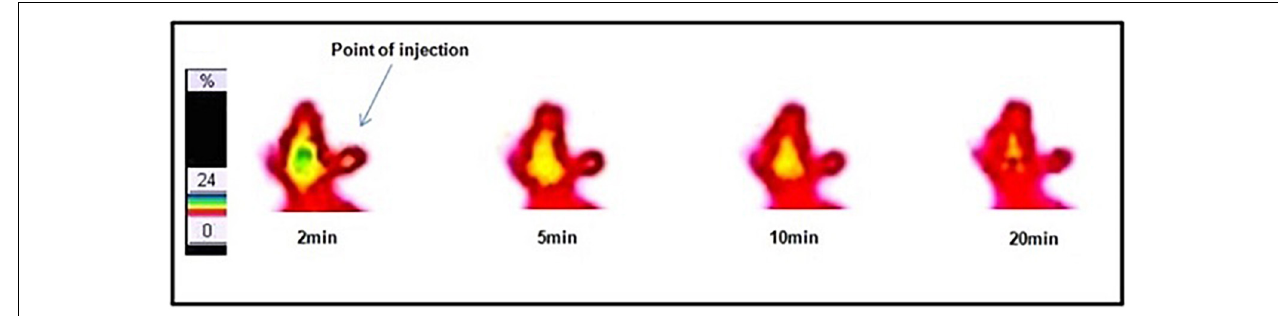
FIGURE 7 | Dynamic lateral planar single photon emission computed tomography (SPECT) images of rabbit after i.v. injection of 99m Tc–DT(Ch) 2 .